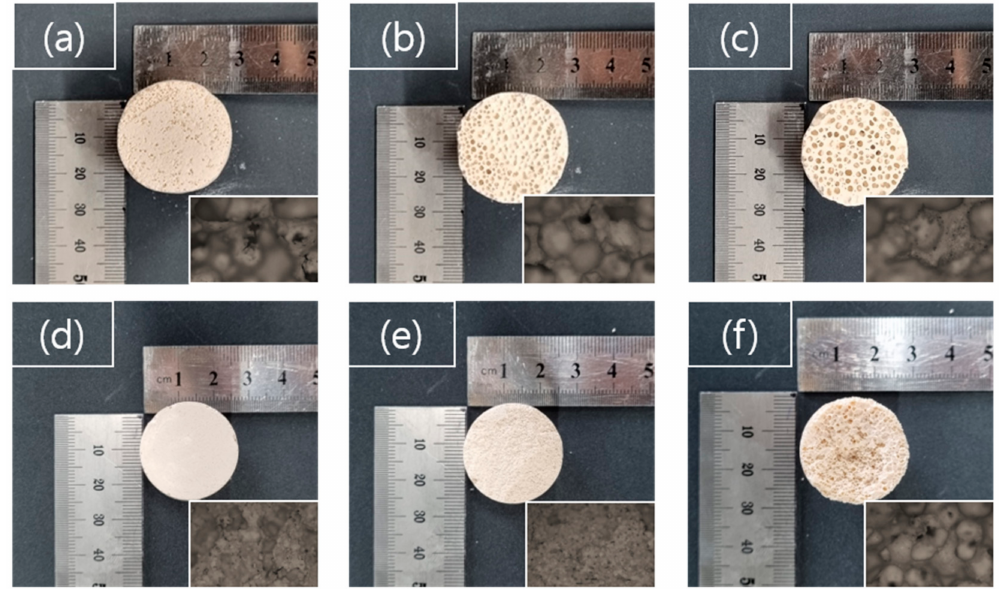
Figure 4. Appearance of GP foams derived by ( a ) H -5%, ( b ) H -10%, ( c ) H -15% and ( d ) HS -5%, ( e ) HS -10%, ( f ) HS -15% optical microscope